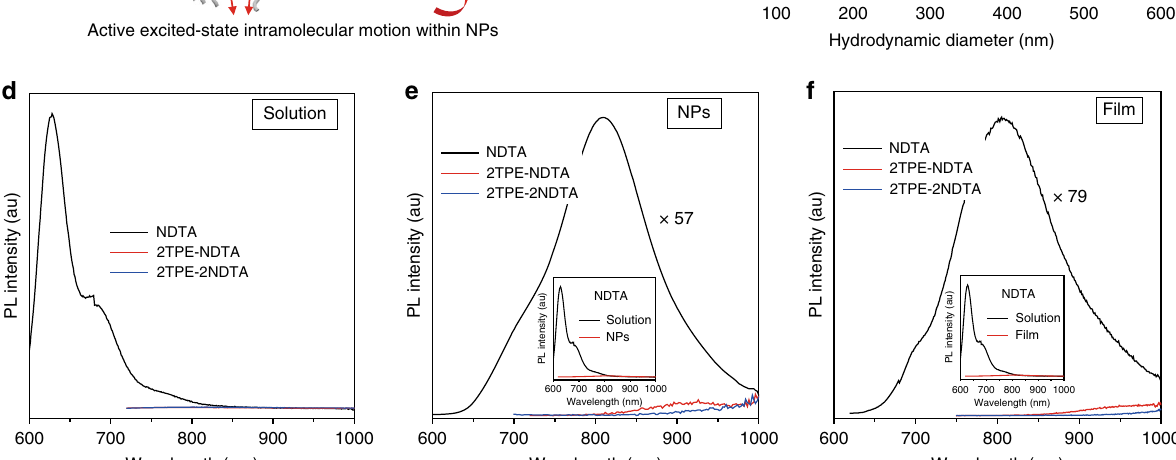
Fig. 1 Preparation and characterization of the compounds and NPs. a Molecular structures of NDTA, 2TPE-NDTA, and 2TPE-2NDTA. b Schematic of 2TPE- NDTA-doped NP, showing active excited-state intramolecular motion within NPs. c Dynamic light scattering pro fi les of the NPs indicated. Inset: transmission electron microscopy image of 2TPE-2NDTA-doped NPs. Scale bar, 200 nm. d – f The photoluminescence (PL) spectra of NDTA (black), 2TPE- NDTA (red), and 2TPE-2NDTA (blue) in THF solution ( d ), the doped NPs ( e ) in water and thin fi lms ( f ). Inset: the contrast of the PL intensity of the as- prepared NPs in water and in a THF solution of NDTA ( e ), and the contrast of the PL intensity of thin fi lm and THF solution of NDTA ( f